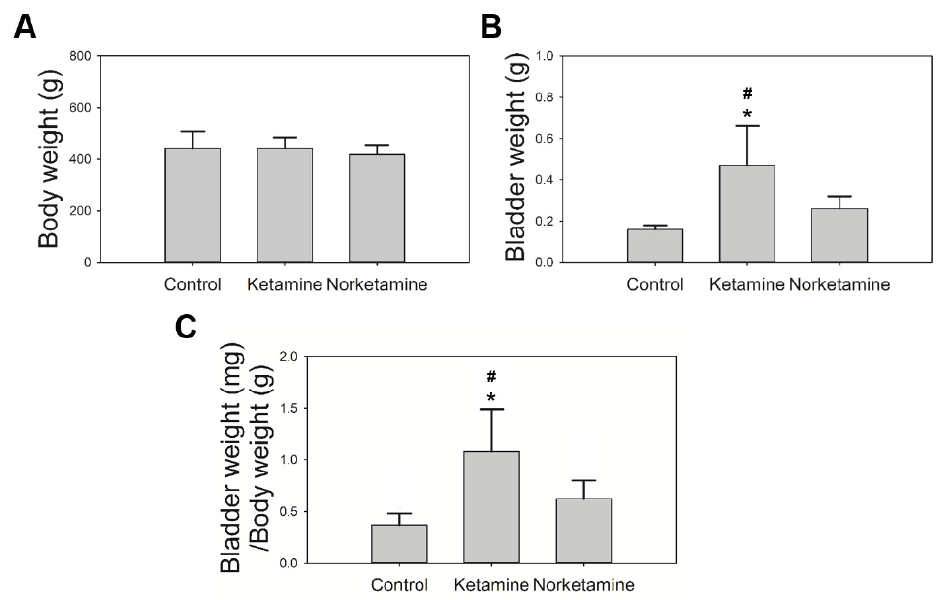
Figure 1. The body weight and bladder weight of rats in each group. The body weight ( A ) was recorded after administering the treatment for 4 weeks; the bladder weight ( B ) was recorded after euthanization; the bladder/body coefficient was calculated ( C ). * indicates statistical differences in comparison with the control group, p < 0.05; # indicates statistical differences in comparison with the norketamine group, p <